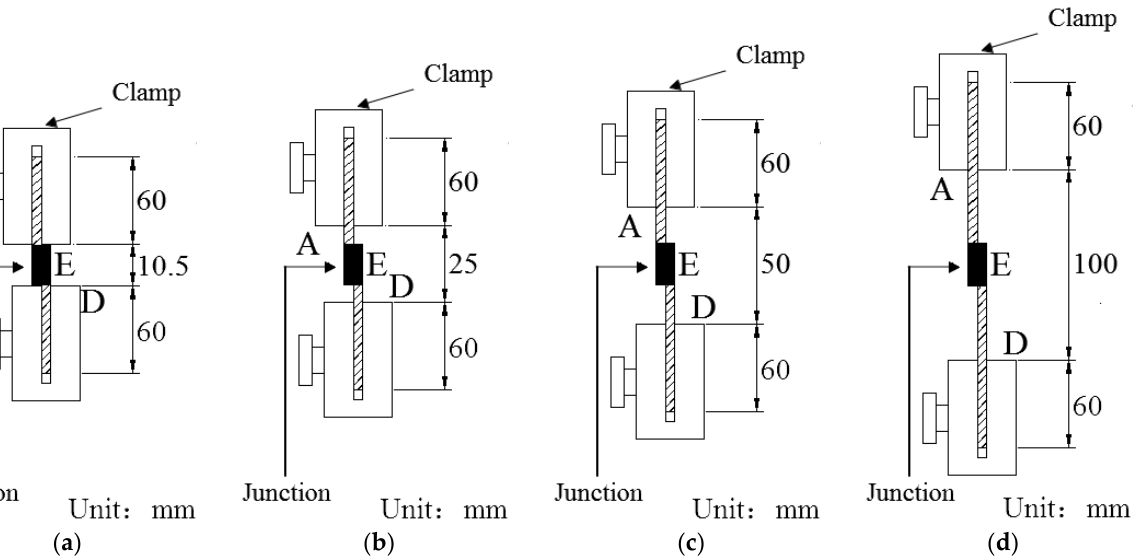
Figure 6. Tensile shear tests under different clamping distances: ( a ) 10.5 mm, ( b ) 25 mm, ( c ) 50 mm, ( d ) 100 mm.